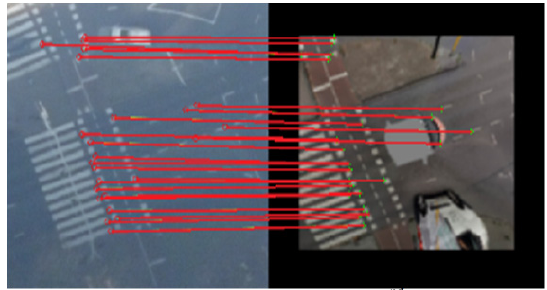
Figure 8 Förstner/SURF matching result of 2 nd tile